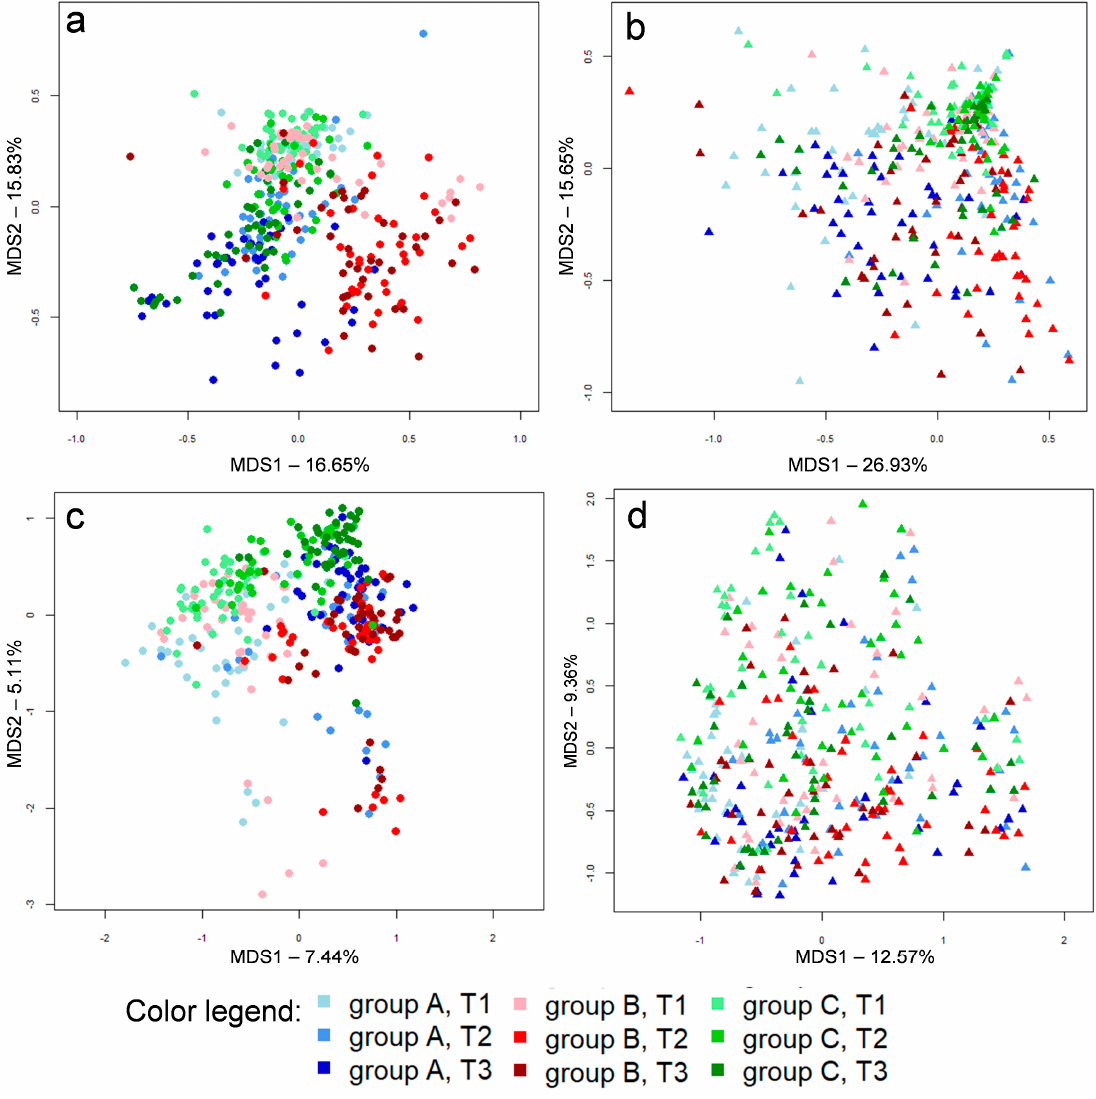
Figure 1. Principal coordinates analyses (PCoA) based on weighted ( a , b ) and unweighted ( c , d ) UniFrac distances of caecal ( a , c ) and ileal ( b , d ) microbiota profiles in broilers in groups A (shades of blue), B (shades of red) and C (shades of green). Samples are depicted as dots for caeca and triangles for ileum, filled in different shades of color, from light (earlier samples, day 15, T1) to dark (later samples, day 42, T3), according to the color legend (provided at the bottom). First and second coordination axes are reported in each plot. Percentages of variation in the datasets explained by each axis are reported.